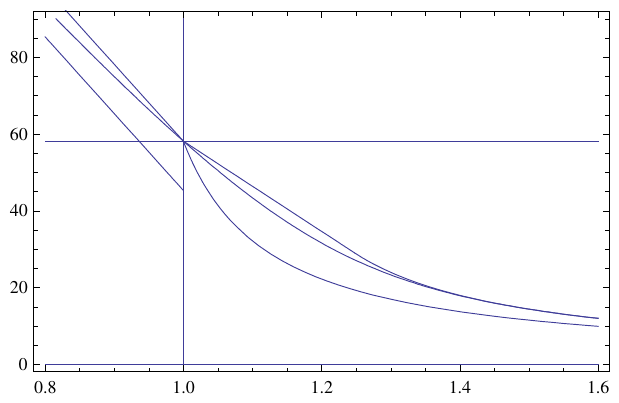
( c | ϑ ) of the variable c > 0 ( X -axis), as ϑ = 1 , α = 0 . 1 , Figure 3. The function u α,t t = 200 , and the bounds of Theorem 3 improved in Theorem